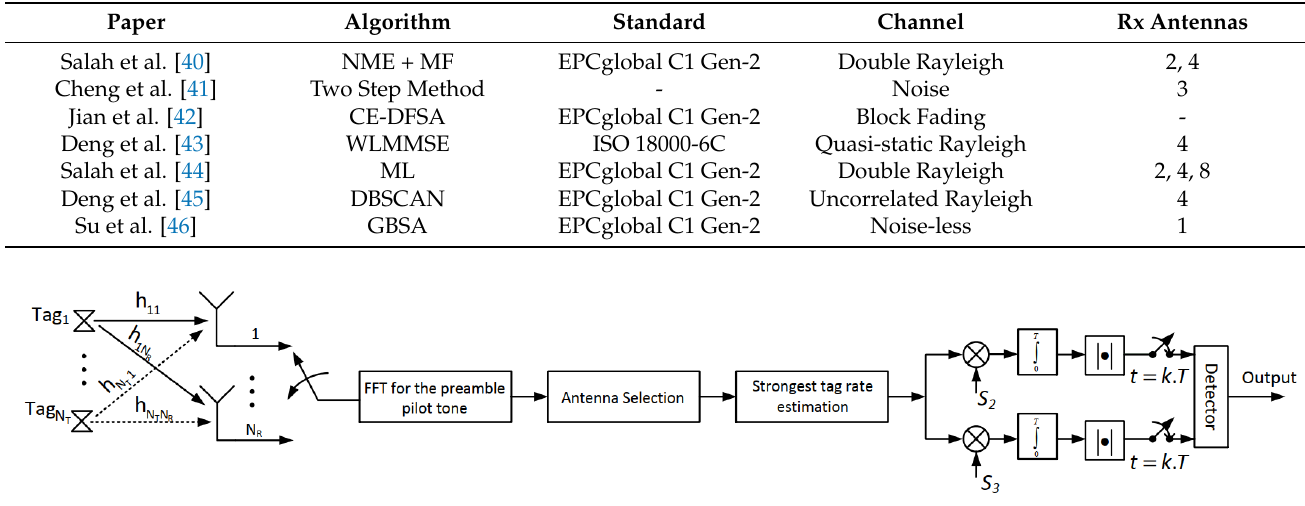
Figure 5. Multi-antenna RFID Reader with collision recovery. Reproduced from [40] with permis- sion from IEEE.